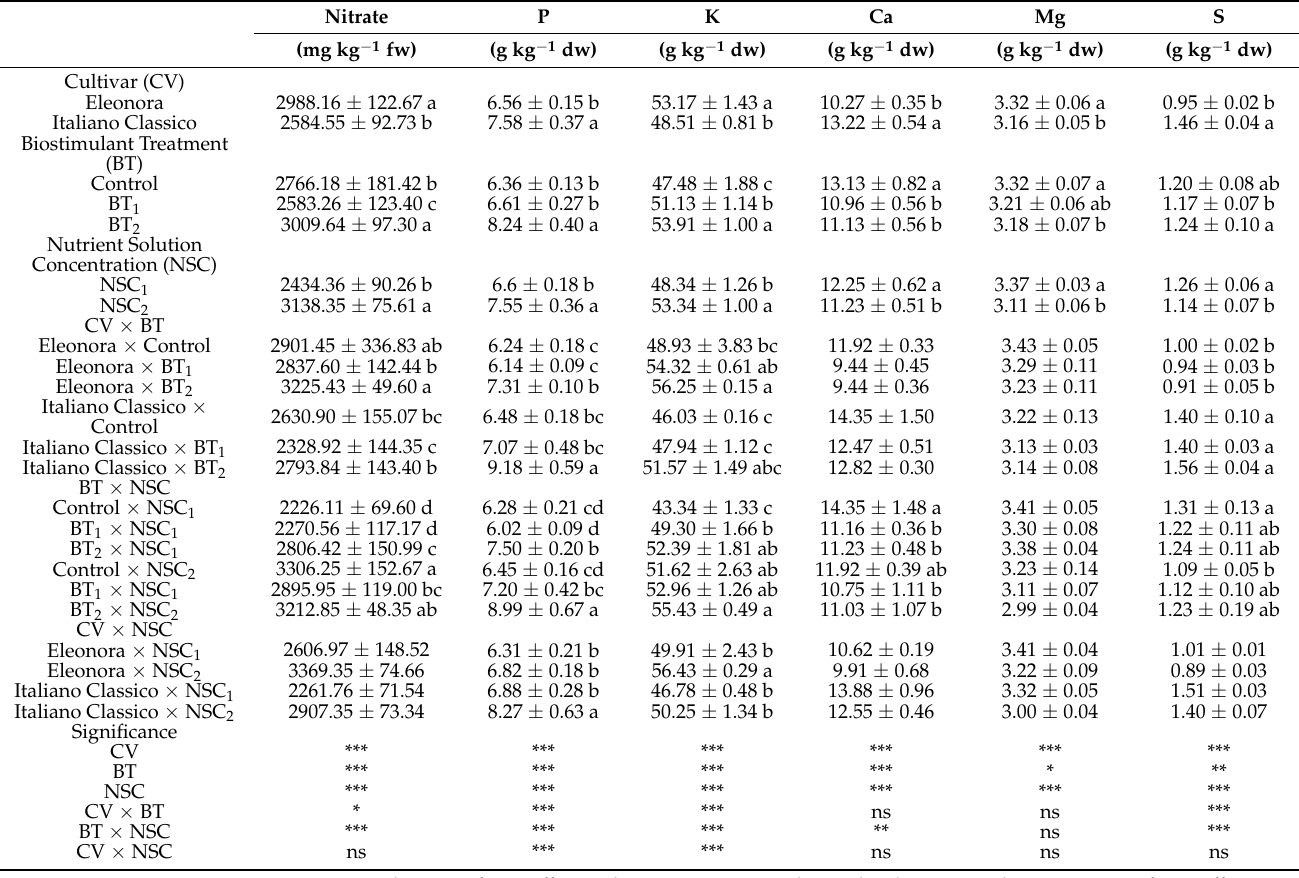
Table 3. Analysis of variance and mean comparisons for the mineral concentration of Eleonora and Italiano Classico basil cultivars grown in floating raft system under two different nutrient solutions treatments and two rates of biostimulant application.